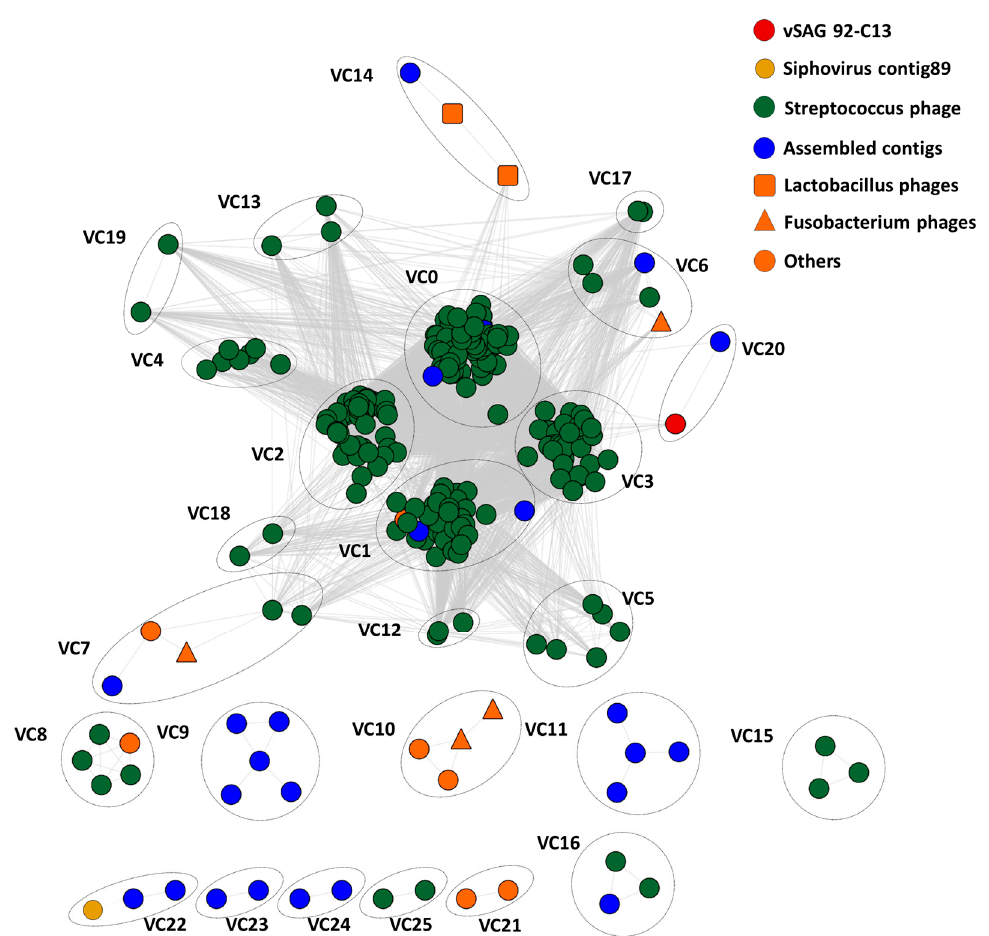
Figure 6. Protein-sharing viral network of oral viruses. (See Supplementary methods for details about the construction of the network.) Approximately genus-level groupings are shown as viral clusters (VCs). The network is built based on the relations (edges) between all proteins of 482 oral cavity viruses. Genomes were from this study, viral isolates were from the Genbank database, and viral contigs were from Pride and colleagues [18] and also from this study. The vSAG 92-C13 (indicated by a red circle) is related to one of the largest Streptococcus phage VCs, the VC3. Note that a total of 210 singlet clusters, each formed by one viral contig, are not depicted in the viral network.